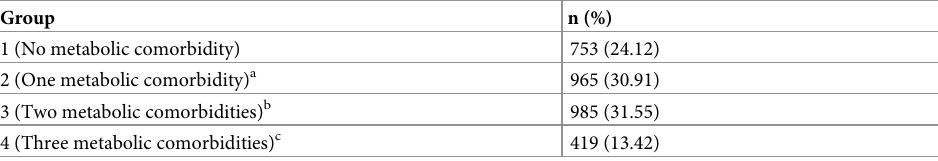
a One metabolic comorbidity means having one metabolic disease among hypertension, diabetes, or dyslipidemia with PAD. b Two metabolic comorbidities mean having two metabolic diseases among hypertension-diabetes, hypertension- dyslipidemia, or diabetes-dyslipidemia at the same time. c Three metabolic comorbidities mean having all metabolic diseases including hypertension, diabetes, and dyslipidemia.